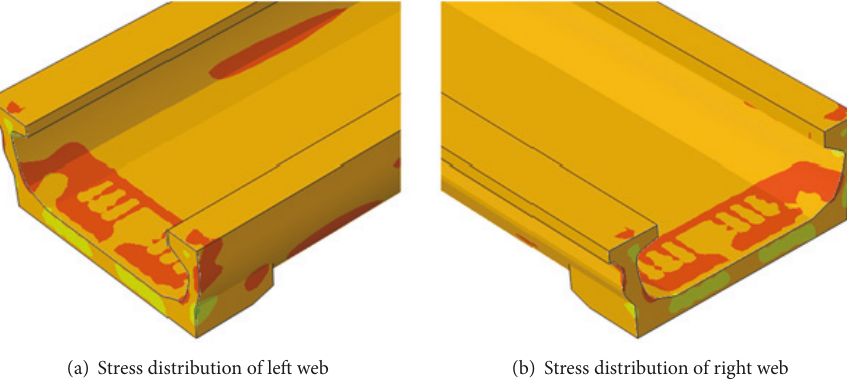
Figure 17: Stress contours at the end of U-shaped girder after tensioning with Parameter 2.